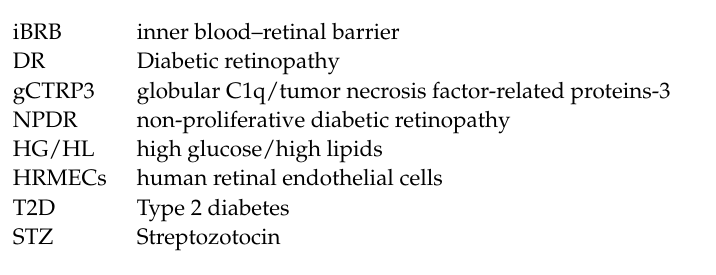
retinopathy mice model; Figure S2: The baseline of techniques of xCELLigence and Schematic Figure of Transwell permeability assay; Figure S3: he characterization of mice